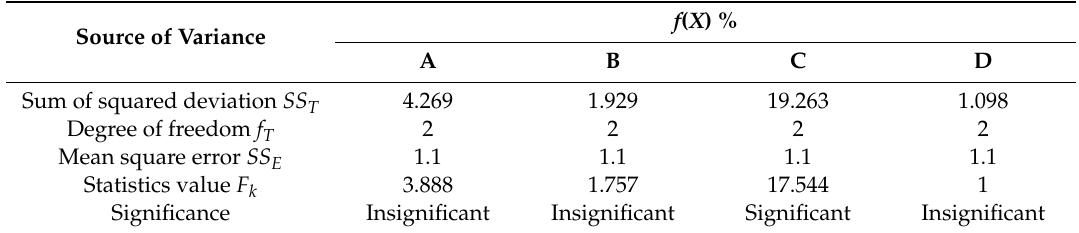
Table 7. Analysis of